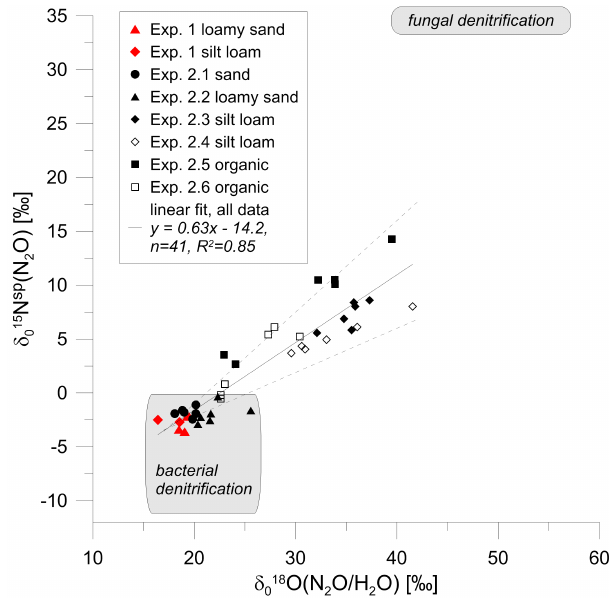
Figure 5. Relation between δ 15 N sp of produced N 2 O and rel- 0 ative ratio difference between produced N 2 O and soil water ( δ 18 O(N 2 O / H 2 O)). Red symbols: Exp 1; black symbols: Exp 2; 0 open symbols: incubations with lower WFPS (70%); filled sym- bols: incubations with higher WFPS (80%). Note that the same symbol shapes always represent the same soil. Grey dashed lines represent the possible range of linear fit when extreme values of isotope effects for N 2 O reduction are assumed in correction calcu- lations (Eq. 5). Range of values for fungal denitrification from Rohe et al.